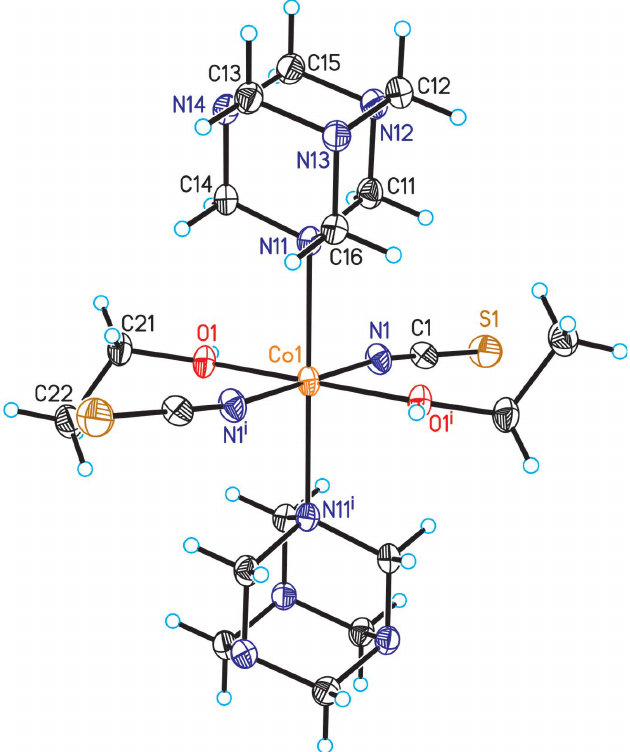
Figure 1 Crystal structure of compound 1 with labeling and displacement ellipsoids drawn at the 50% probability level. Symmetry codes for the generation of equivalent atoms: (i) (cid:4) x + 1, (cid:4) y + 1, (cid:4) z + 1.